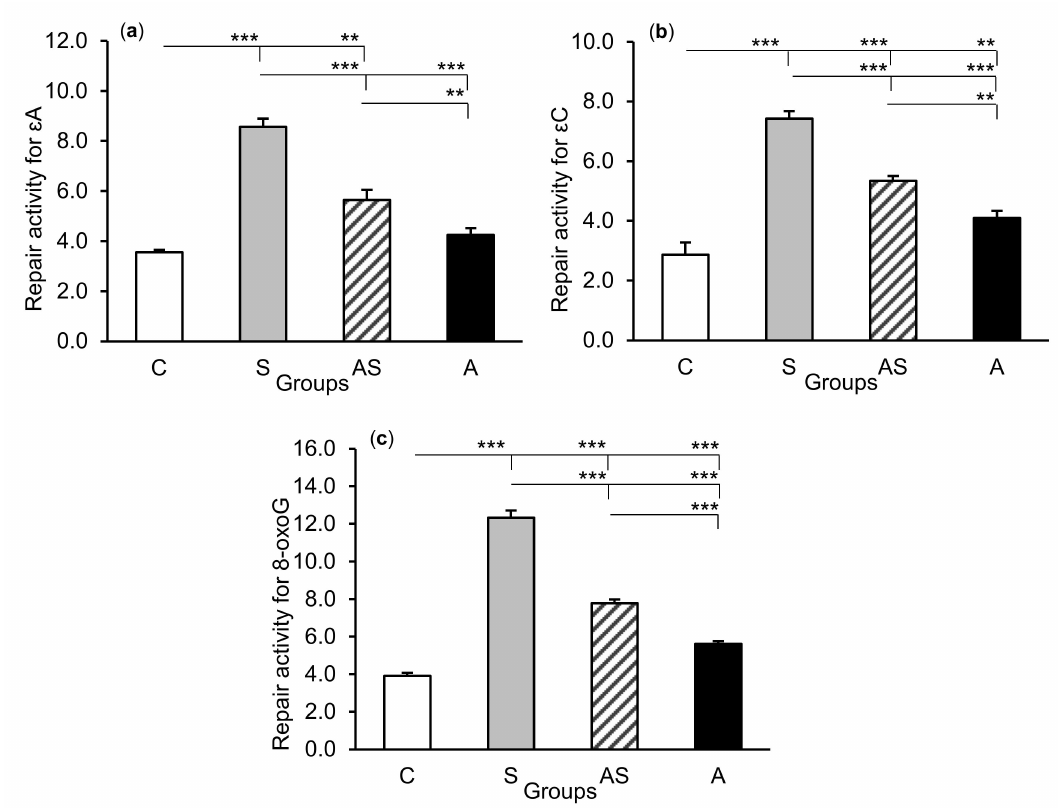
Figure 6. Repair activities (fmol / µ g protein / h) for 1, N 6 -ethenoadenine ( ε A), ( a ) 3, N 4 -ethenocytosine ( ε C), ( b ) and 8-oxoguanine (8-oxoG), ( c ) in the hippocampal CA3 field of sheep treated with: vehicle (C), vehicle and stressful stimuli (S), allopregnanolone and stressful stimuli (AS), and allopregnanolone alone (A). Significance of di ff erences: ** p < 0.01, *** p <